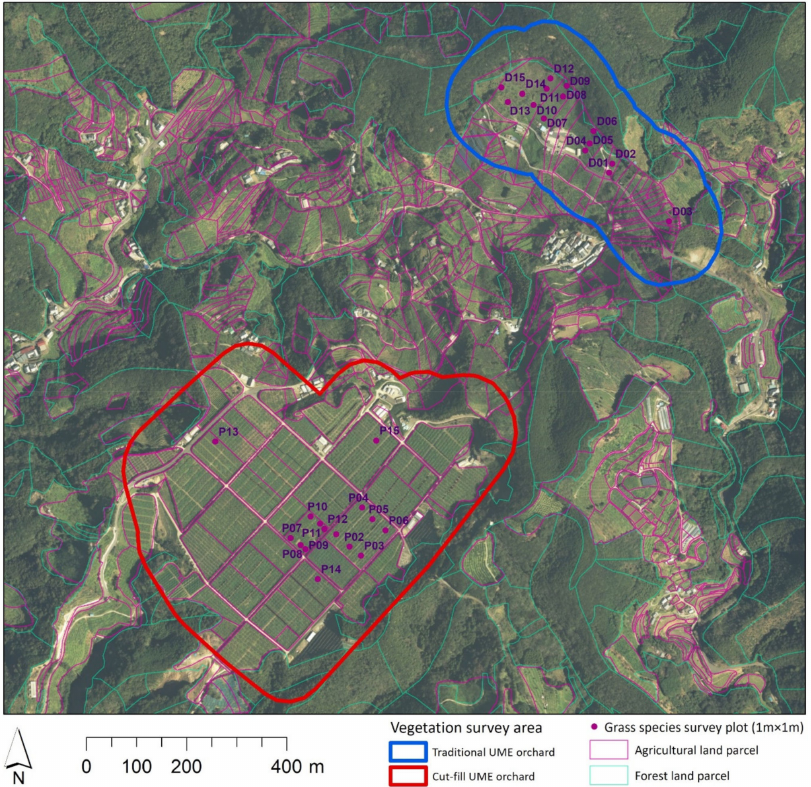
Figure 2. Zoomed-in image of our sample field survey sites (parcel data is adapted from